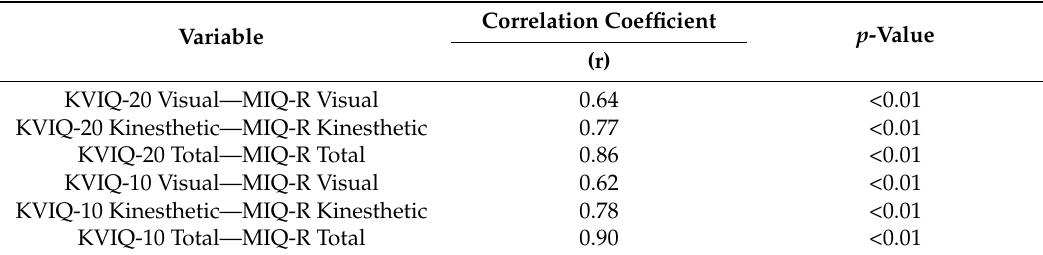
Table 3. Spearman’s rank correlation coefficients between scores for the KVIQ-20/KVIQ-10 and the